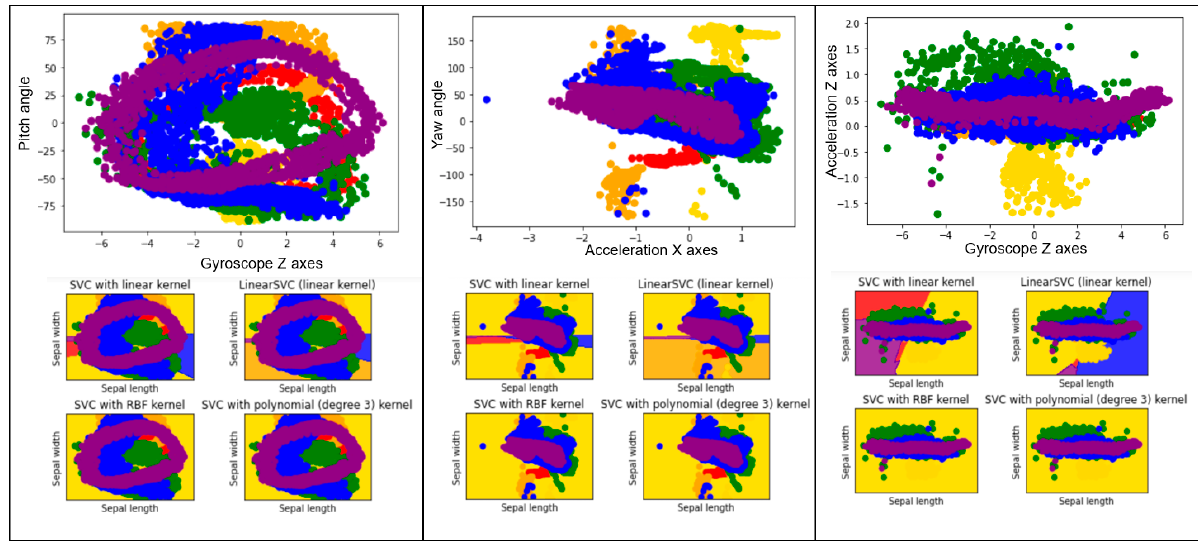
Figure 9. The decision surface for four different SVM classifiers of mode dumbbell exercises (red = Bicep, orange = Deltoid, lack = Tricep, green = Shoulder, blue = Squat, purple = Side and lunge).